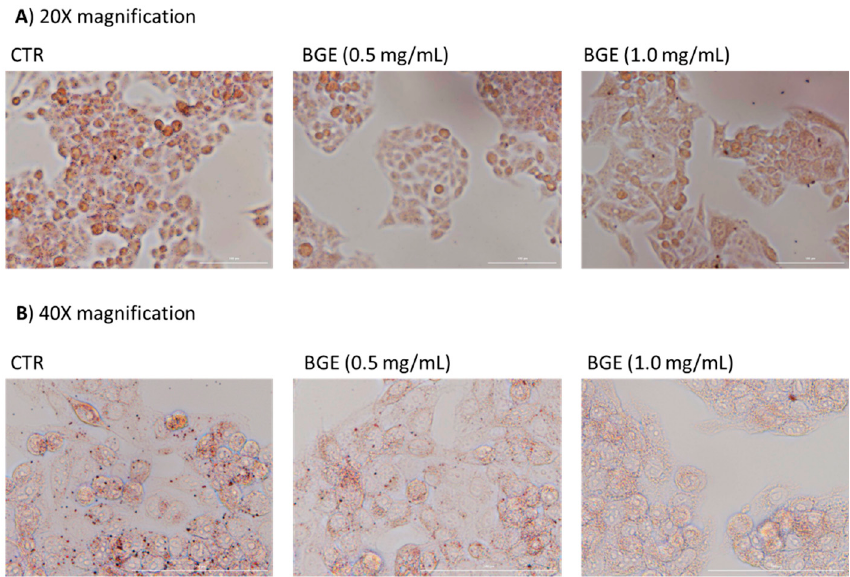
Figure 3. BGE reduces neutral lipid accumulation in HepG2 cells exposed to high glucose. ( A ) ORO staining microscopy at 20X magnification revealed a decrease of lipid droplets in cytoplasm of BGE-treated HG-HepG2 cells compared to untreated control cells (CTR); ( B ) lipid droplets decrease in cytoplasm of BGE-treated HG-HepG2 cells was more clearly revealed by ORO staining microscopy at 40X magnification.